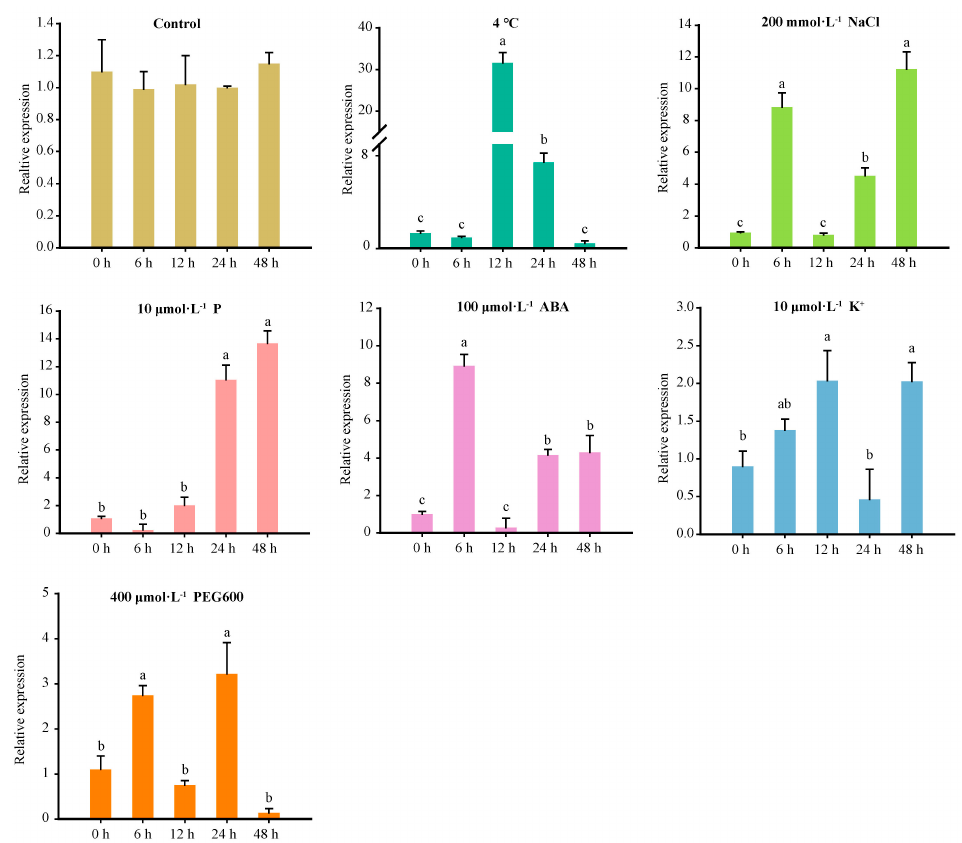
Figure 3. Expression patterns of FaWRKY71 under different abiotic stresses. Multiple comparisons were tested using Turkey’s test and significant differences ( p < 0.05) were indicated by different lowercase letters.